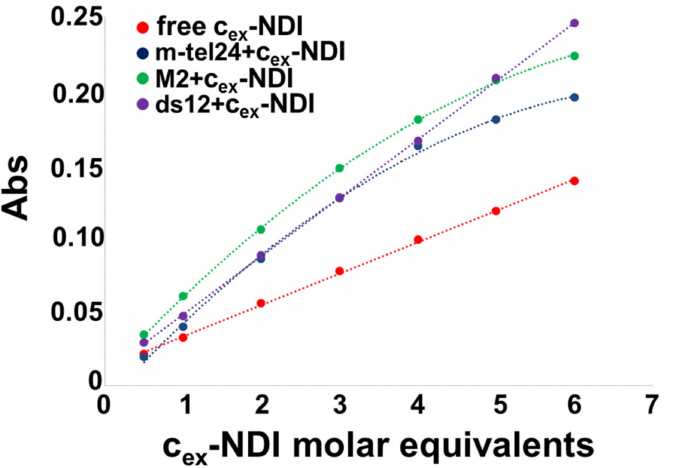
Figure 6. Absorbance at 597 nm as a function of the c ex -NDI molar equivalents for free c ex -NDI and for m-tel24 G-quadruplex, M2 G-quadruplex and ds12 duplex titrated with c ex -NDI (up to 6 molar